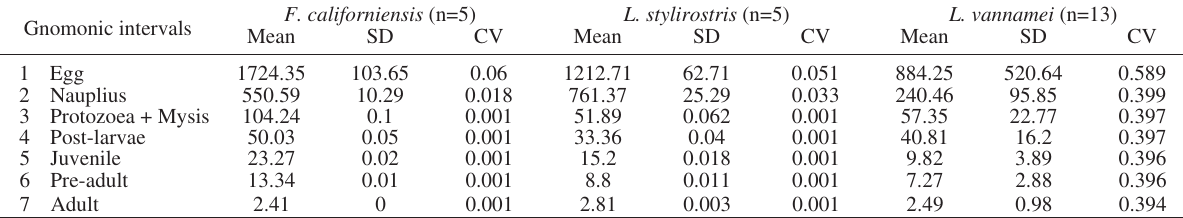
Table 6. – Variation due to different egg duration stages for the white ( L. vannamei ), blue ( L. stylirostris ), and brown ( F. californiensis ) shrimps using the gnomonic model; n, number of different egg duration stages used in the estimation; SD, standard deviation; CV, coefficient of variation.